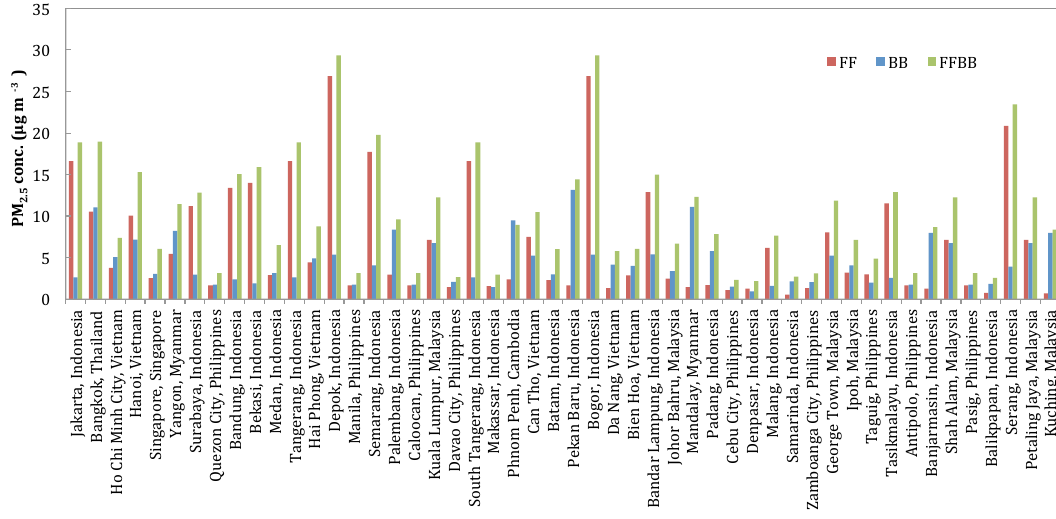
Figure 5. The annual mean simulated PM 2 . 5 concentration (µgm − 3 ) in 50 Association of Southeast Asian Nations (ASEAN) cities, derived from FF (red), BB (blue), and FFBB (green) simulations and averaged over the period 2002–2008.